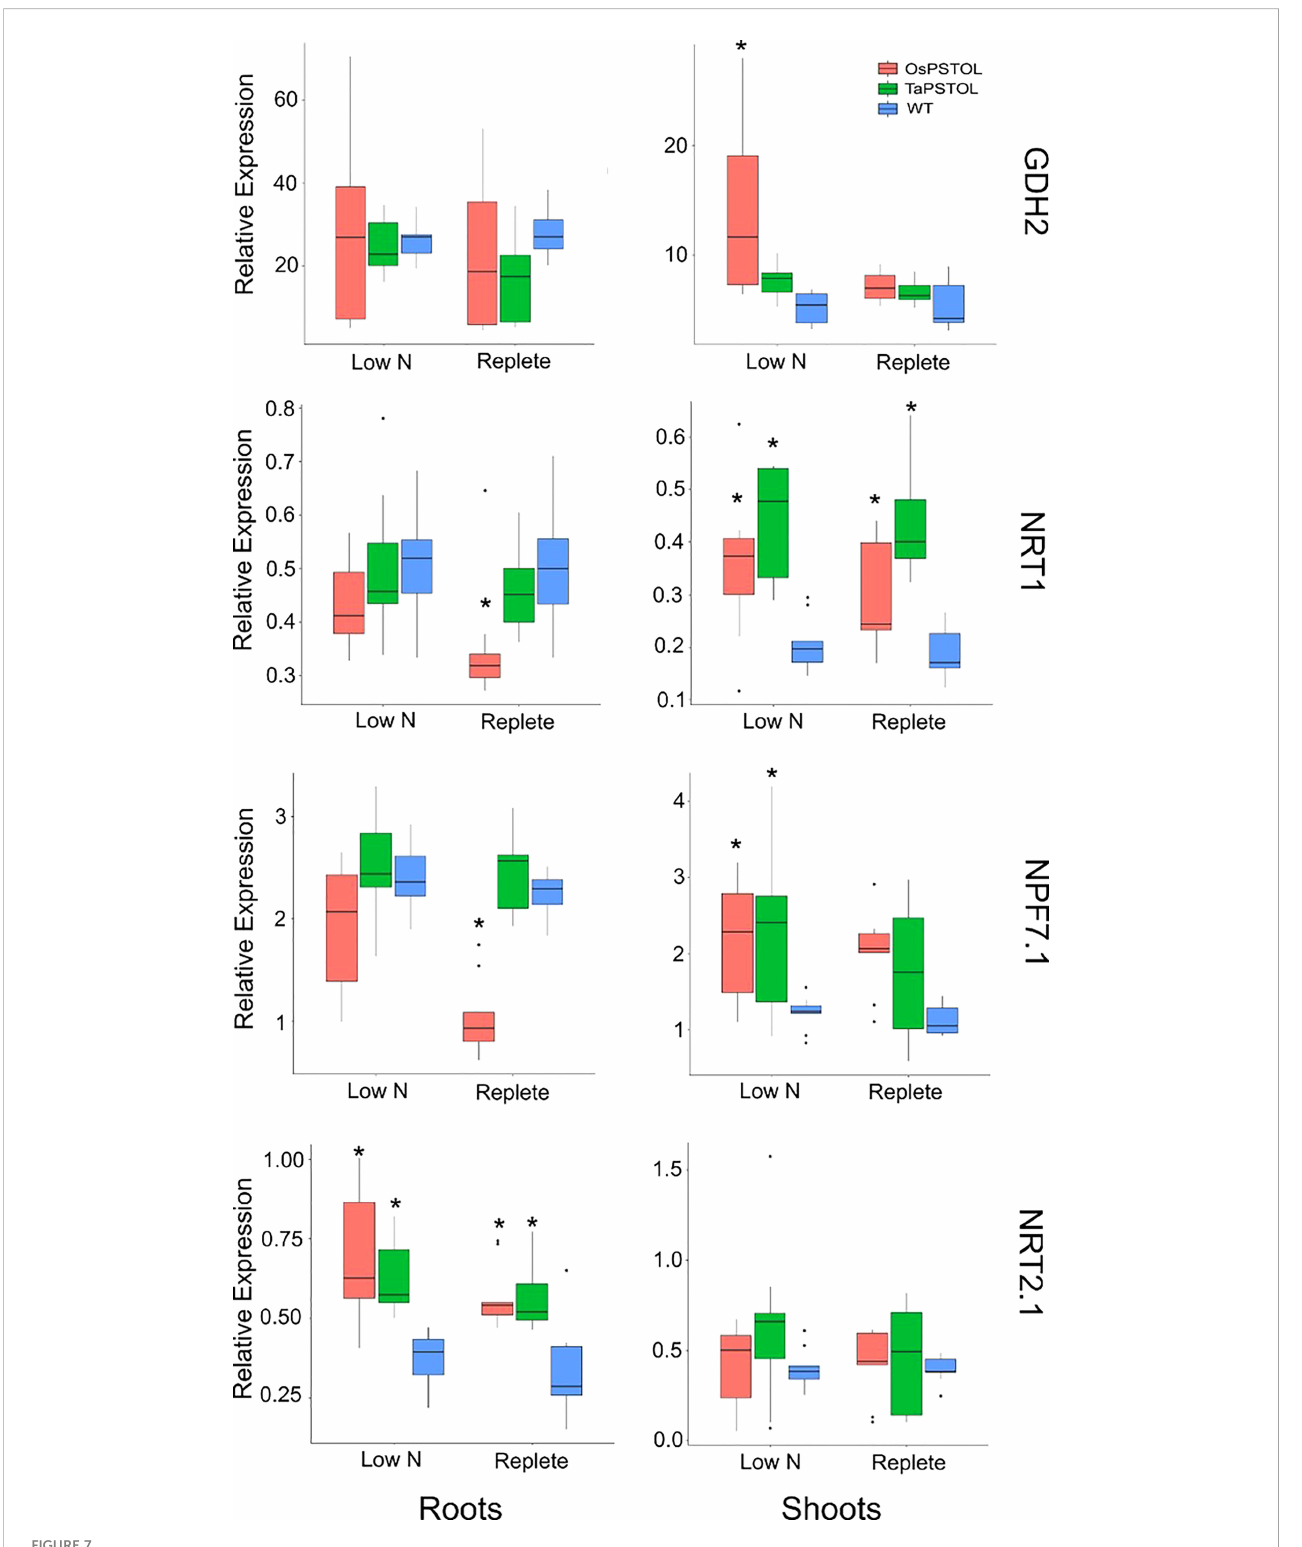
FIGURE 7 Transcript levels for N regulated genes TaNRT1 , TaNRT2.1 , TaNPF7.1 , and TaGDH2 in transgenic wheat plants expressing either OsPSTOL (OsOE-3) or TaPSTOL (TaOE-1). Expression values shown are relative to the expression of TaUbi under in wheat plants grown under low nitrogen (low N) and replete nitrogen (replete) levels in hydroponic solution. Root speci fi c expression is in the panels on the left and shoots speci fi c expression in panels on the right for each gene. Data shown as the mean values (central line), lower and upper quartiles (box), minimum and maximum values (whiskers), and outliers as individual points. The statistical analysis was performed with ANOVA and post hoc Tukey test, * correspond to signi fi cant differences between transcript levels of either line under either treatment